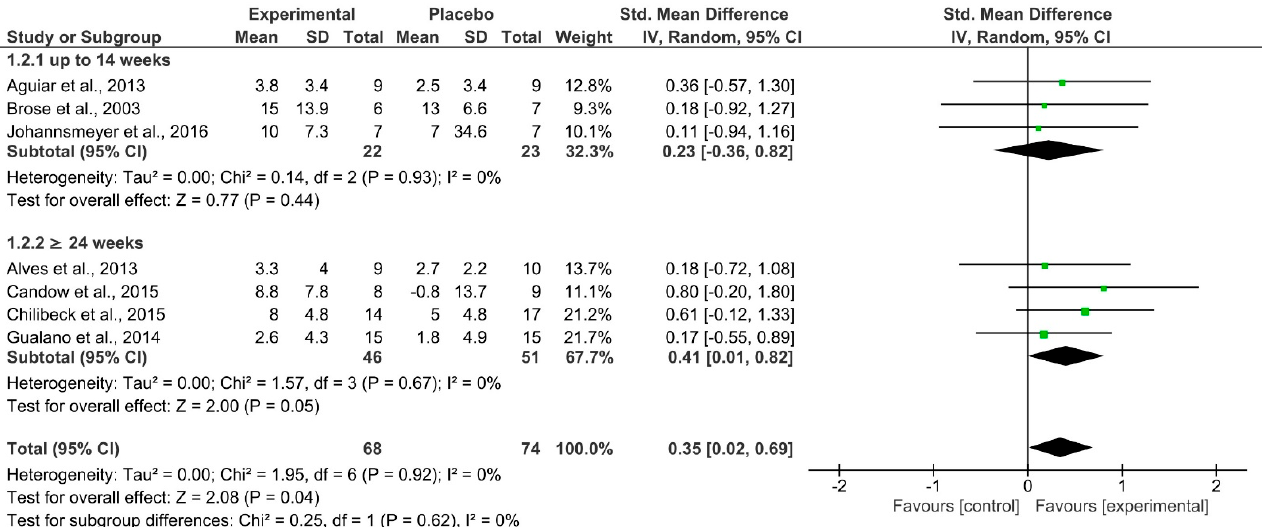
Figure 3. Forest plot for analysis of muscle strength of the upper body during the bench press or chest press exercise, separated by subgroups according to study duration (up to 14 weeks and ≥ 24 weeks).